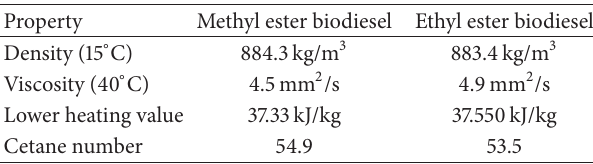
Table 2: Fuel properties [32].